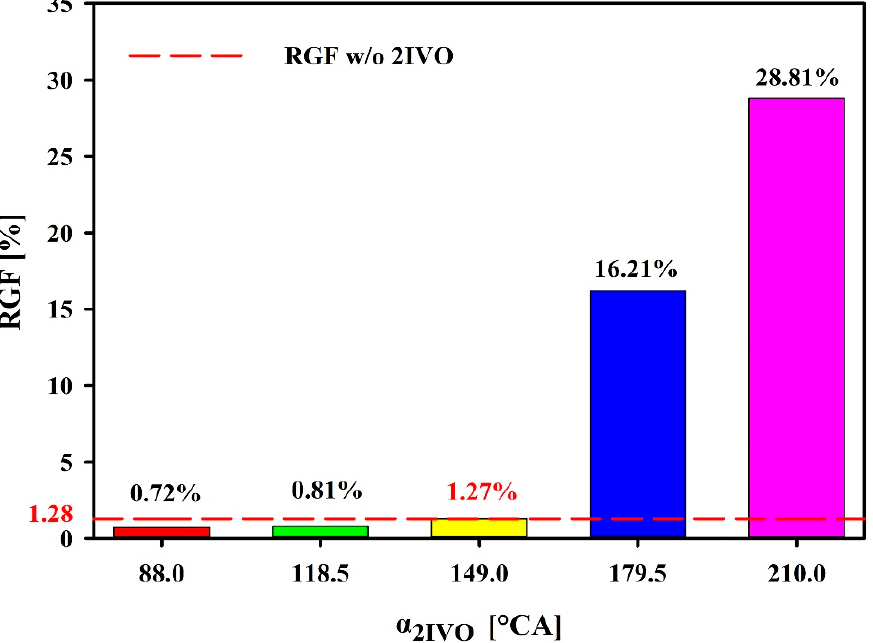
Figure 4. In-cylinder residual gas fraction (RGF) with respect to 2IVO for the single injection case.